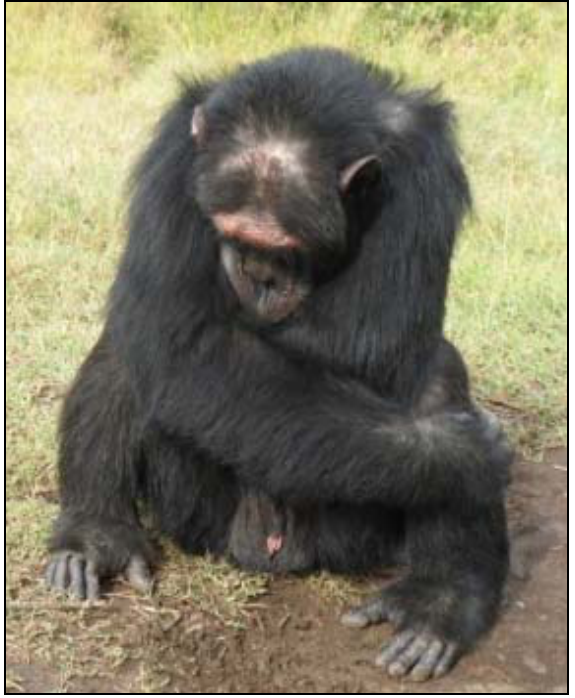
Figure 5. Poco sitting in a depressed, hunched